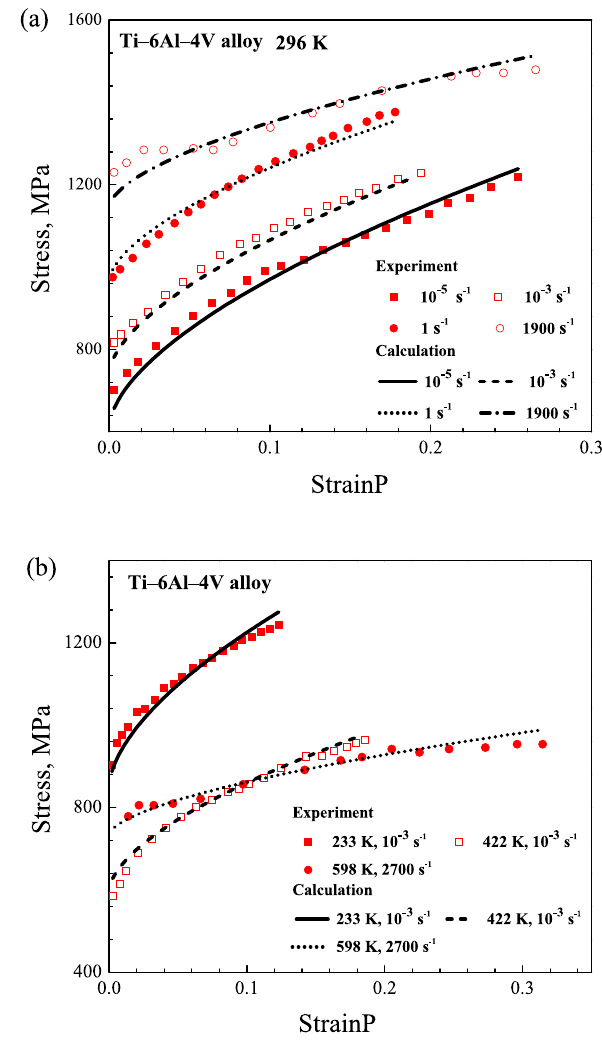
Figure 4. Comparison of stress–plastic strain curves for Ti–6Al–4V alloy between the calculated and experimental results at different temperatures and strain